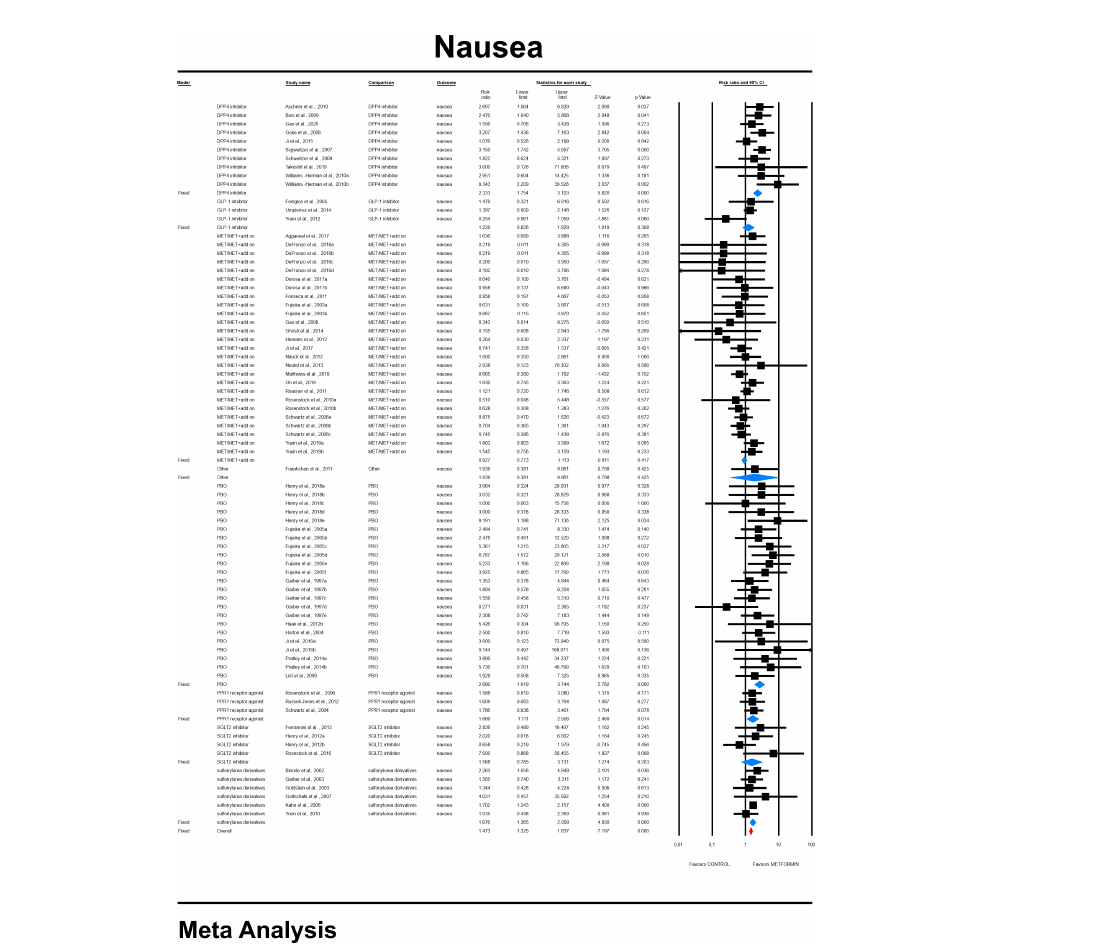
FIGURE 9 The effect size (RR) for nausea in patients taking metformin (intervention) vs. comparator